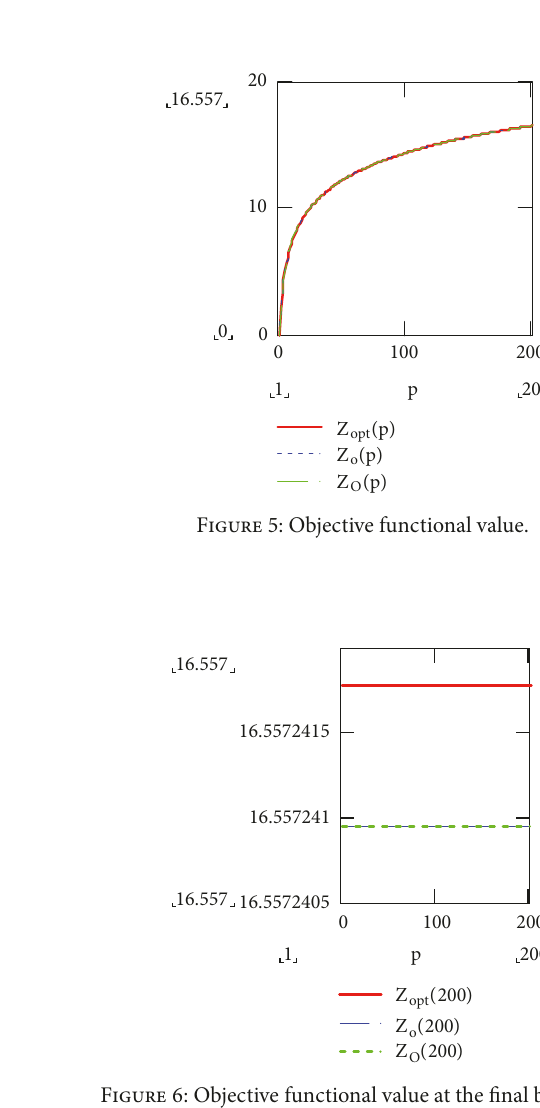
Figure 3: Objective functional value at the final boundary.